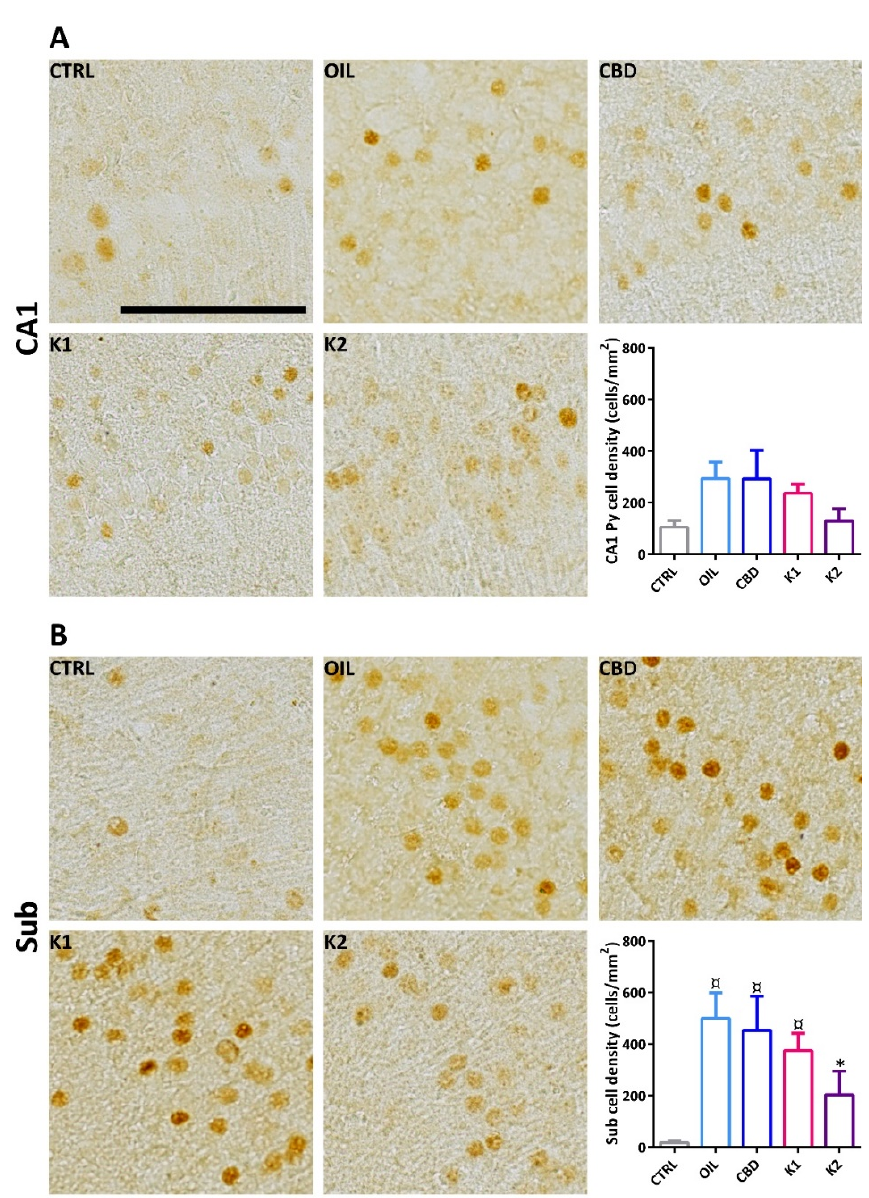
Figure 7. FosB/ Δ FosB immunoreactivity in the hippocampal CA1 region and in the subiculum (Sub) of mice treated with CBD ( n = 6), K1 ( n = 6), K2 ( n = 6), or olive oil ( n = 6), and exposed to different sessions of 6-Hz corneal stimulation. FosB/ Δ FosB immunoreactivity was also illustrated in a representative unstimulated control (Ctrl, n = 6). Particularly, FosB/ Δ FosB immunoreactivity in the CA1 was reported in (A), whereas that of the Sub, in (B). ¤ p < 0.050 vs. CTRL; * p < 0.050 vs. OIL; Duncan’s method. Scale: 0.1 mm. CTRL, control; OIL, olive oil; CBD, cannabidiol; K1, hemp oil 1; K2, hemp oil 2.3. Discussion.